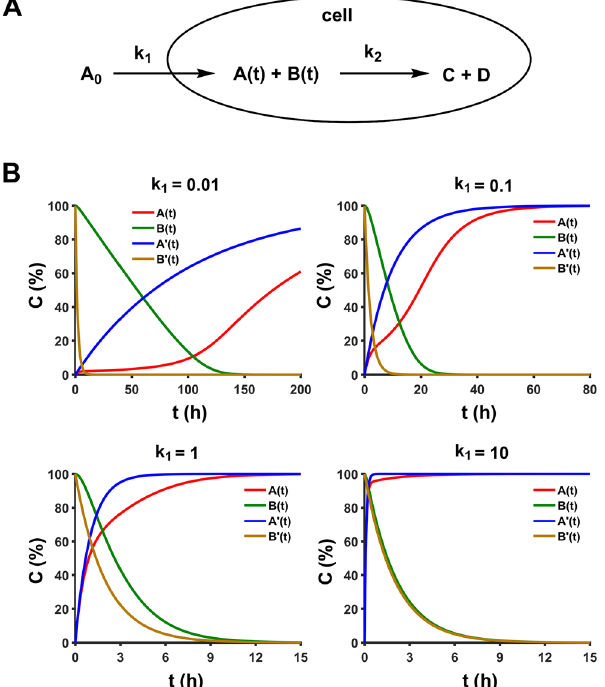
Figure 4. ( A ) Reaction model of drug uptake and action. ( B ) Theoretically simulation results at different initial k 1 conditions ( k 2 = 0.5). A ( t) and B ( t ) were normalized concentration of internal drug and biomolecules, respectively, A ′ ( t ) and B ′ ( t ) were their ideal exponential decay